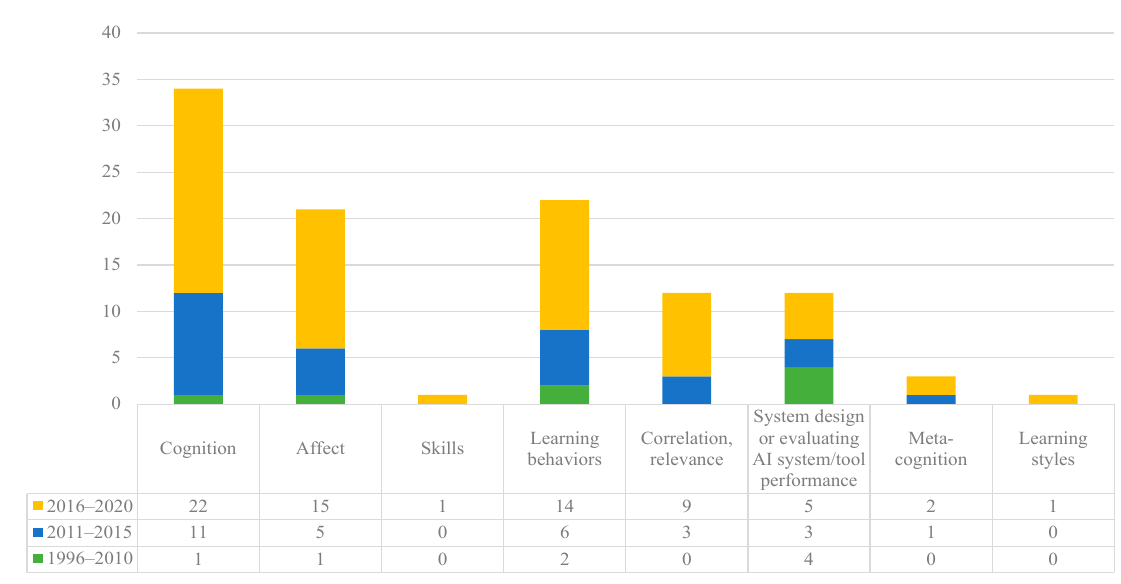
Figure 14. Research issues of AIME research in each period.